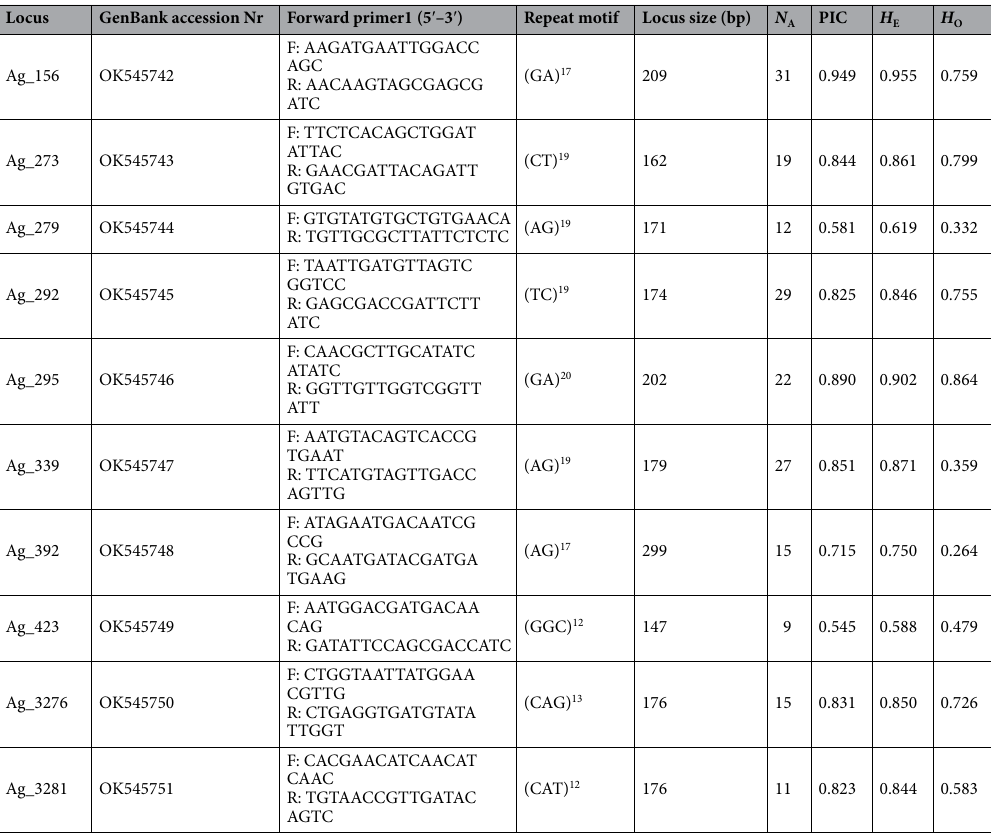
Table 2. Characteristics of newly developed microsatellite loci for Asynapta groverae . N A , Total number of alleles detected; PIC, Polymorphic information content; H E , Expected heterozygosity; H O , Observed